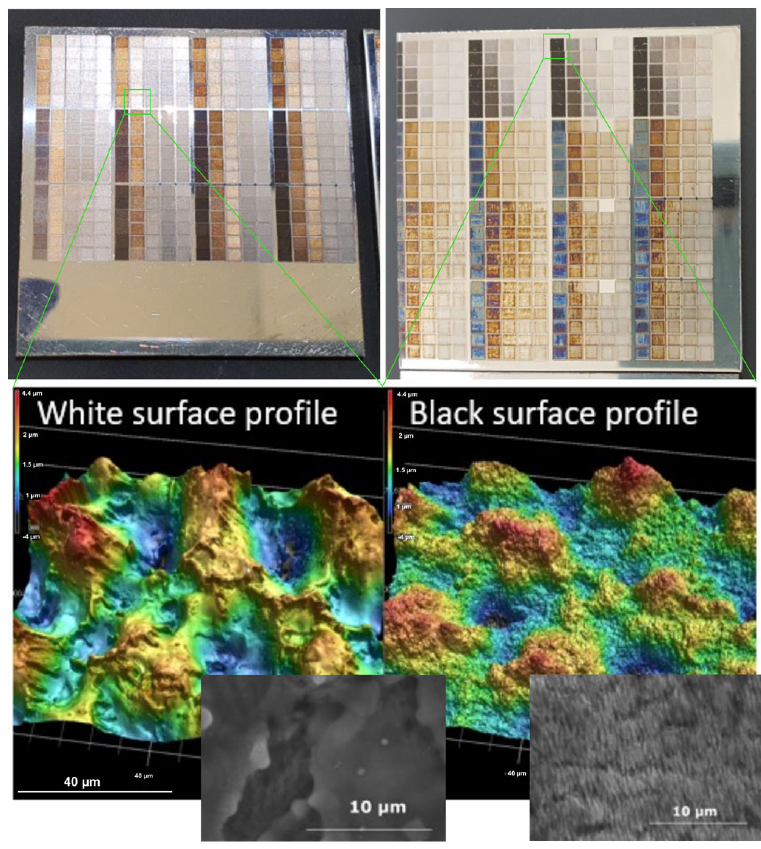
Figure 3. Micromachined surfaces images using different fabrication parameters (as listed in Table 1). The white markings reveal a required microstructure as discussed in Section 2.1, whereas the dark areas may exhibit a similar microstructure; however, with an embedded nanostructure which has light-absorbing properties.